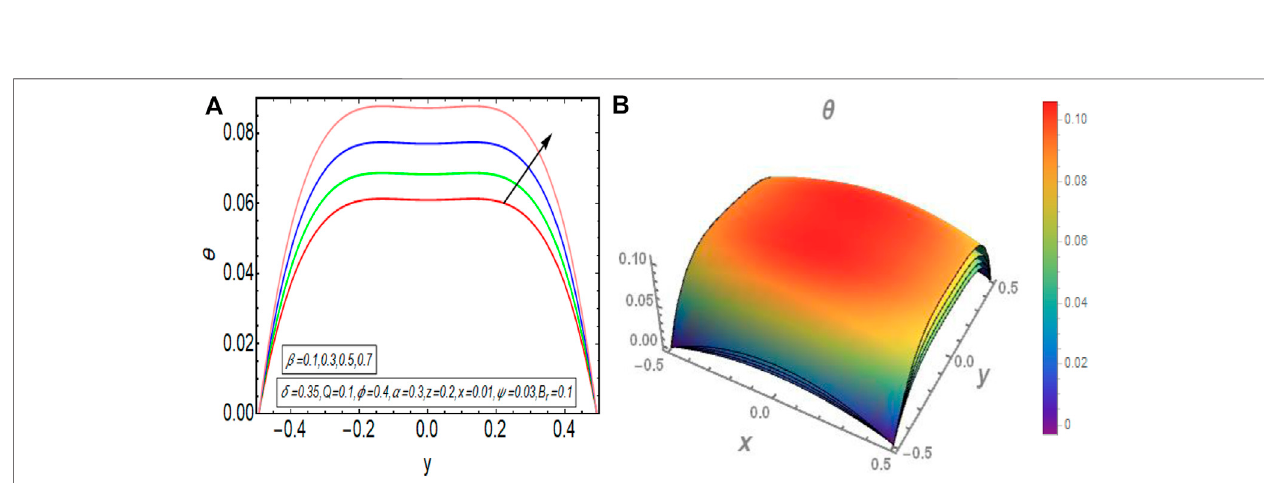
Frontiers in Physics | www.frontiersin.org June 2022 | Volume 10 | Article 923290